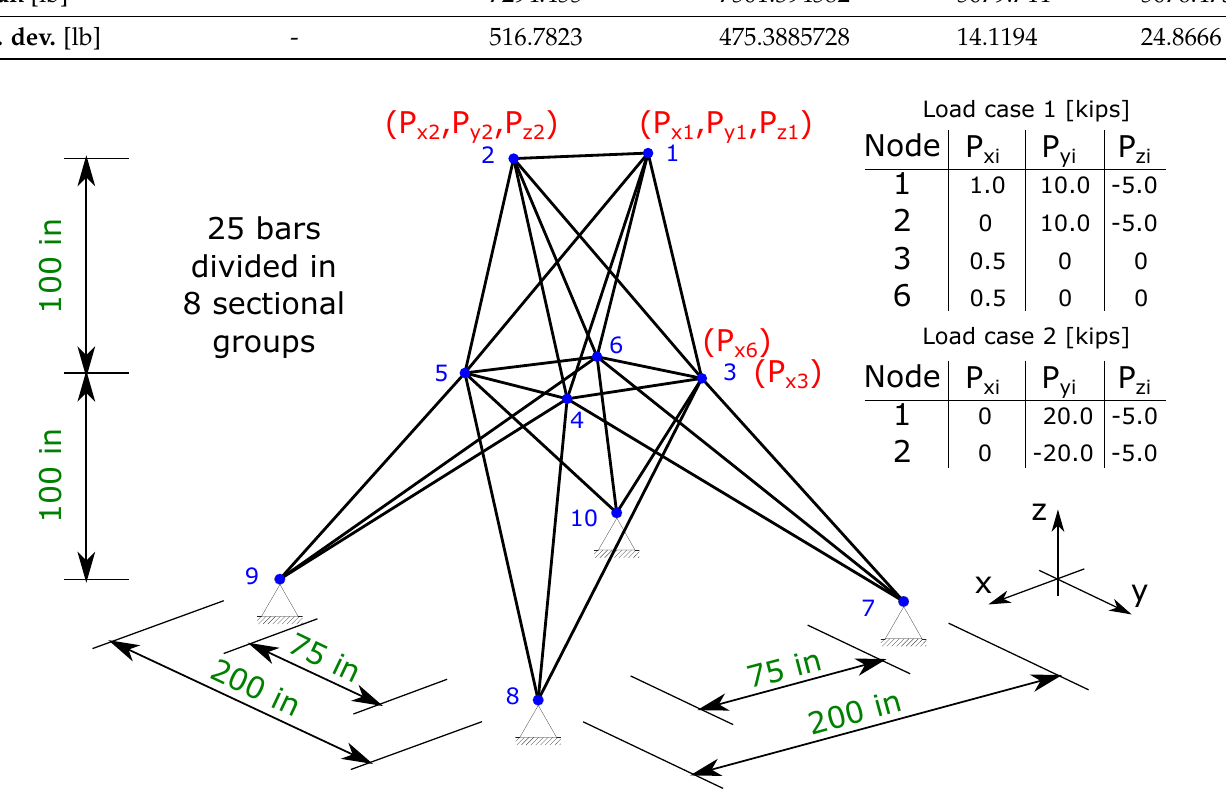
Figure 7. Graphical representation of the 25 bar truss design optimization